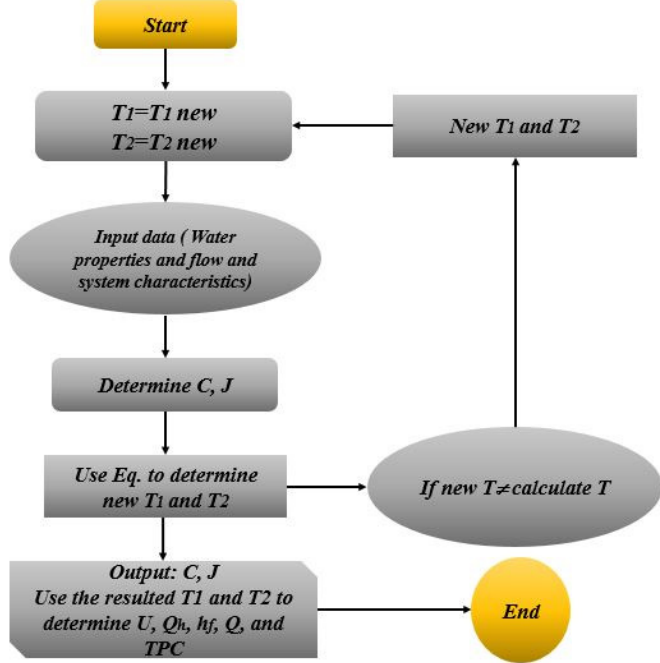
Fig. 1: The MATLAB flowchart of this study.